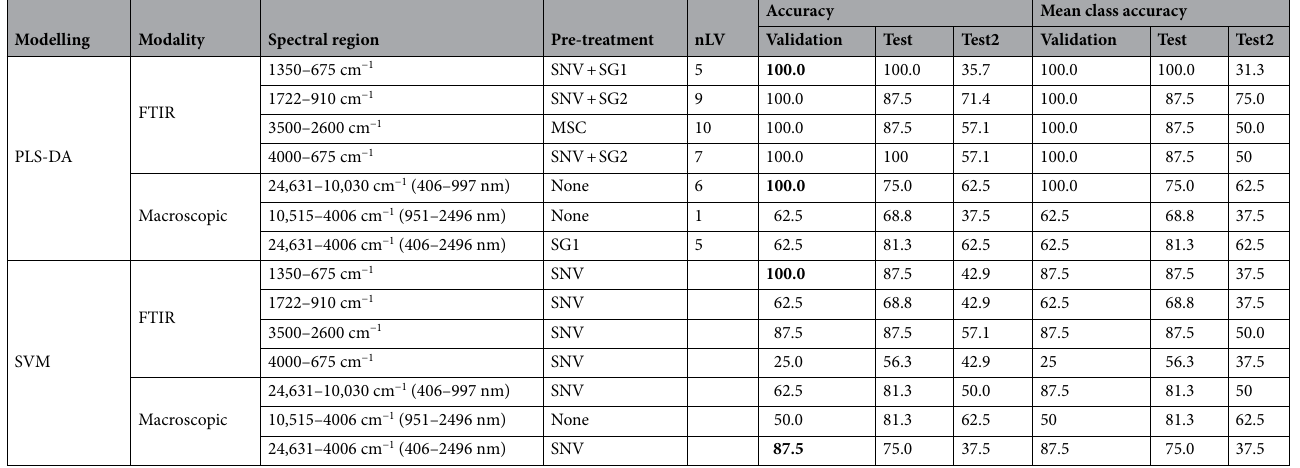
Table 4. Model performances for discrimination between gram-positive BS and LP based on mean spectra. For each modality/spectral region, the model yielding maximum accuracy in the validation set is bolded.